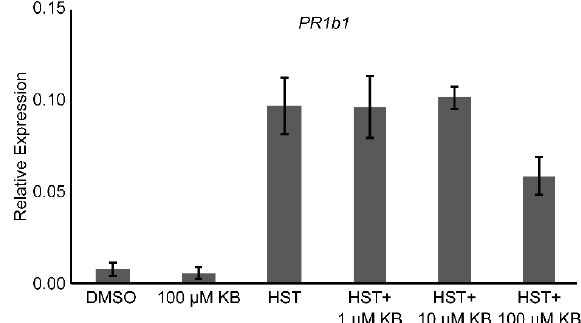
Figure 9. The relative expression level of PR1b1 in the leaves of the tomato cultivar Natsunokoma at 24 h after HST combined with KB. Different KB concentrations (1, 10, and 100 µM) were manually applied by foliar spray at 6 h after HST. Gene expression levels were quantified by qPCR and normalized to GAPDH expression. Vertical bars indicate the standard error of the mean ( n = 4).